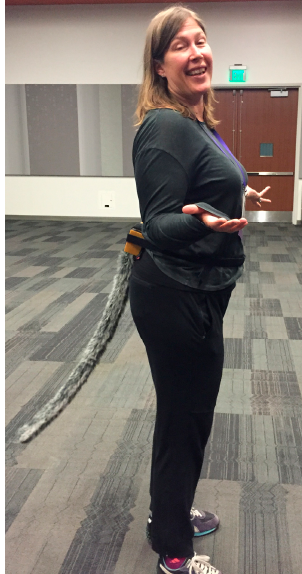
Figure 4. Katherine Isbister wearing the Tail.